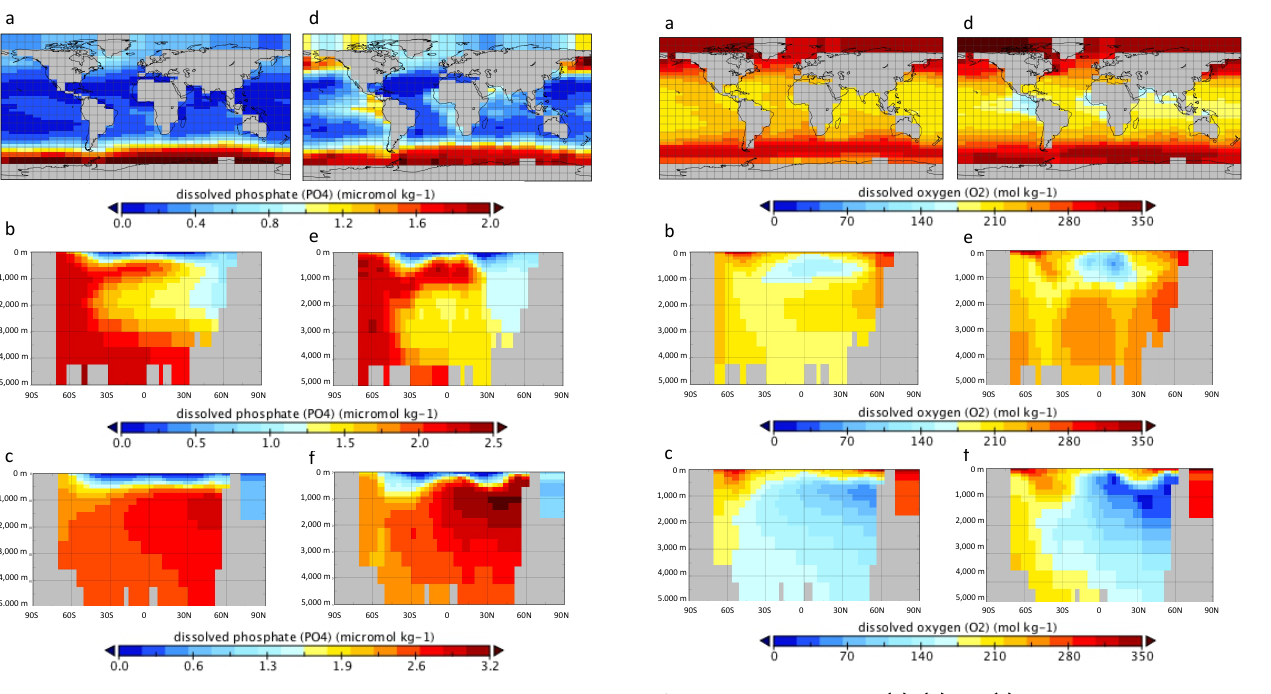
Fig. 5. Dissolved phosphate: (a) , (b) and (c) EFPC ensemble aver- ages, (d) , (e) and (f) observations (Garcia et al., 2006). Upper panels are surface fields ( ∼ 81m depth). Middle panels are Atlantic cross sections (25 ◦ W). Lower panels are Pacific cross sections (155 ◦ W).